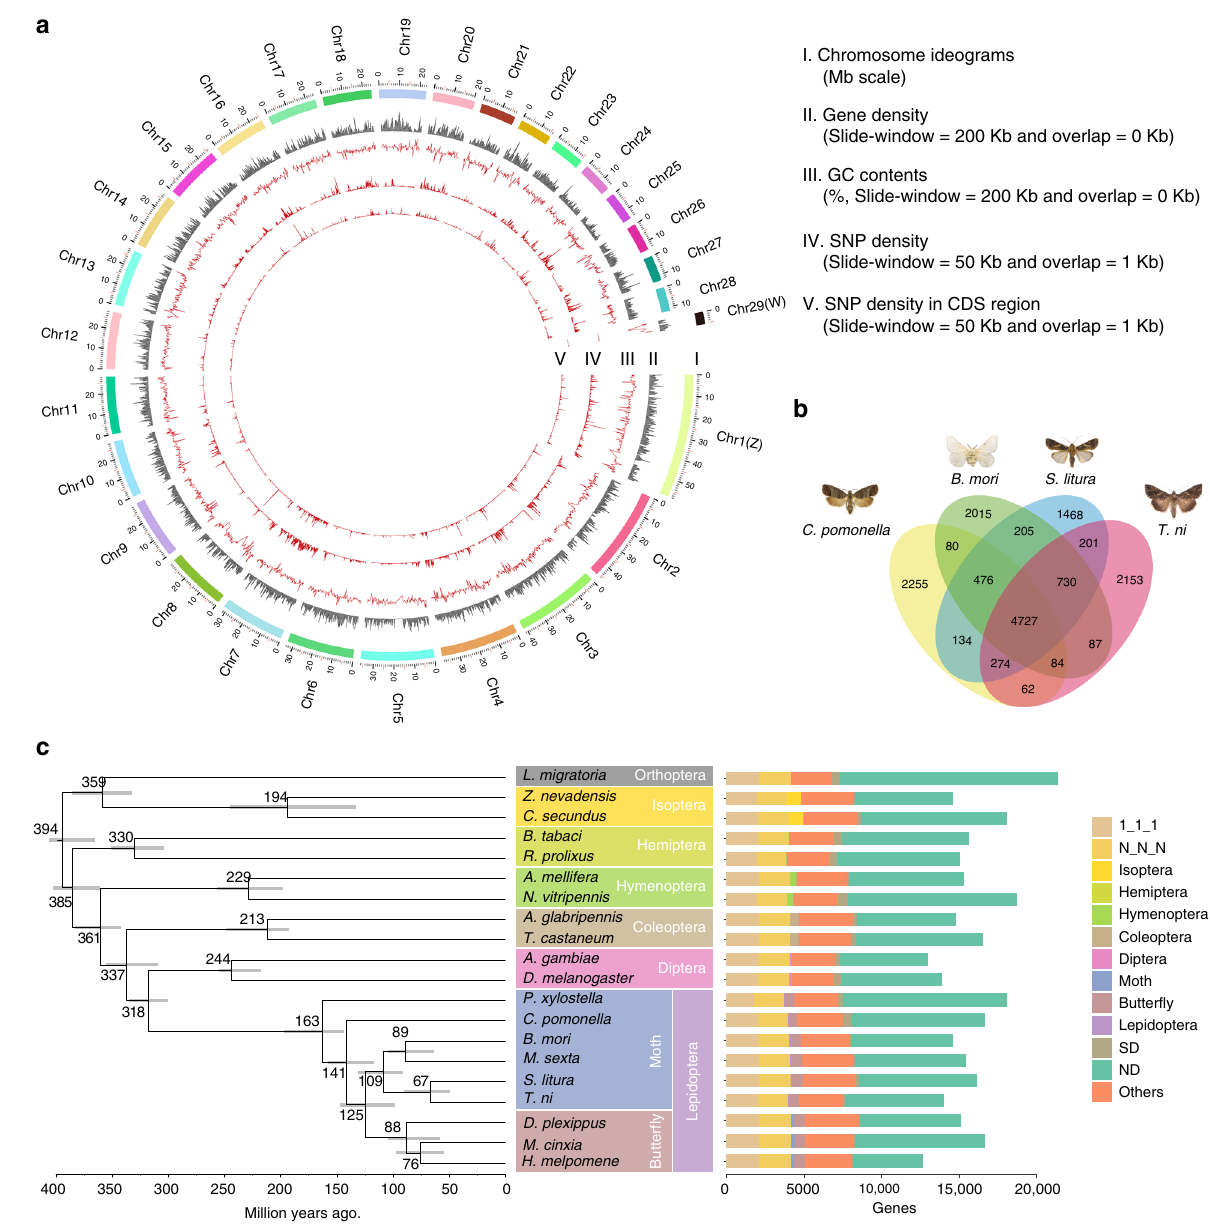
Fig. 1 Genomic characterization and comparative genomics of the codling moth, Cydia pomonella . a Circular diagram depicting the genomic landscape of the 29 codling moth chromosomes (Chr1 – Chr29 on a Mb scale). The denotation of each track is listed in the center of the circle. b The Venn diagram indicates the numbers of treefam annotation families shared among the four Lepidoptera, C. pomonella , Bombyx mori , Spodoptera litura , and Trichoplusia ni . Each gene was blasted with the treefam database with the E -value 1e − 5 and the best hit treefam annotation was selected. c Phylogenetic tree and gene orthology of C. pomonella with 19 insect genomes. The phylogeny was inferred from 500 strict single-copy genes with 59,621 reliable sites by RAxML maximum likelihood methods employing LG + G model and 100 bootstrap replicates. All nodes received bootstrap support = 100. Divergences were estimated by the PhyloBayes Bayesian method using a relaxed clock with nodes calibration (Supplementary Materials): mean age is given for each note with gray bars indicating 95% posterior densities. Bars giving gene counts are subdivided to represent classes of orthology. 1:1:1 indicates universal single-copy genes, duplication in a single genome and absence less than two moth species. N:N:N indicates other universal genes. SD species-speci fi c duplicated genes, ND species-speci fi c genes. Others indicates all other orthologous